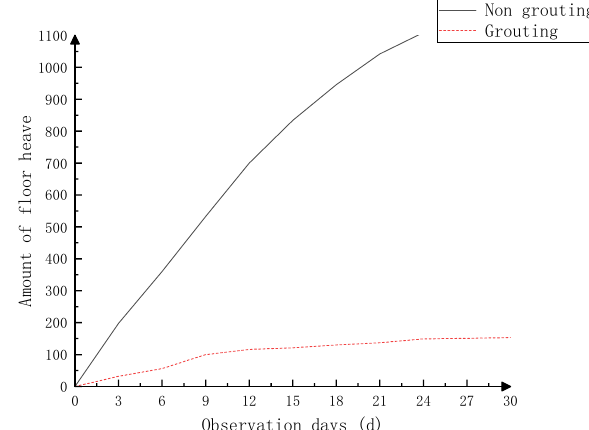
Figure 14. Comparison of nongrouting and grouting bottom heave